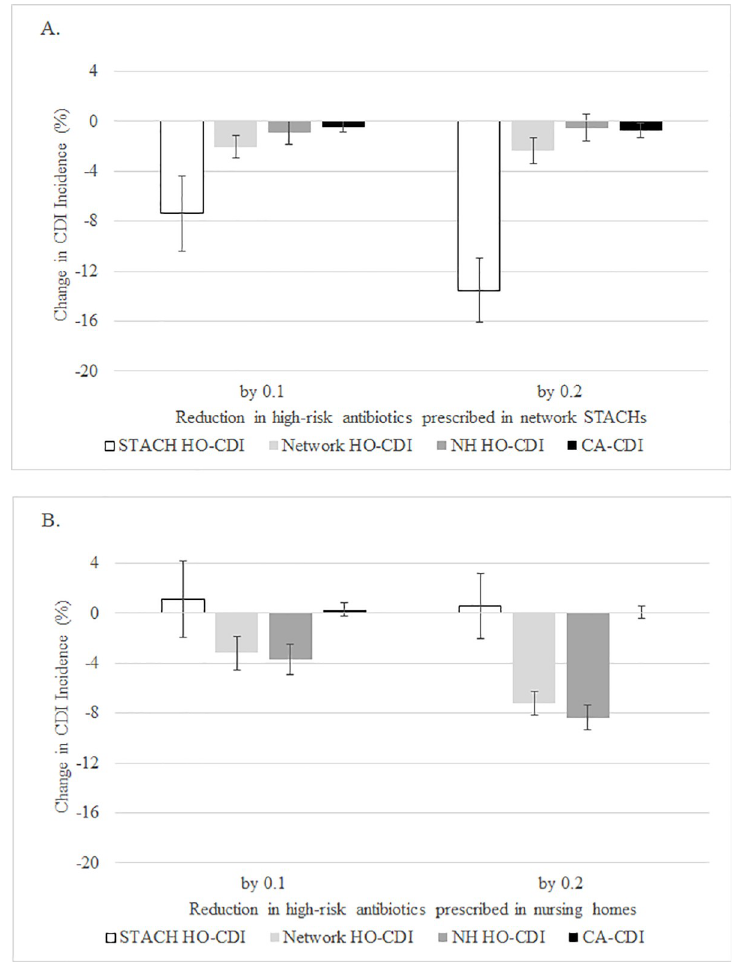
Fig 3. Clostridioides difficile infection (CDI) incidence and reductions in high-risk antibiotics prescribed. Scenarios as follows: (A) at network STACHs only; and (B) at nursing homes only. For each scenario, the relative proportion of CDI high-risk antibiotics was reduced by 0.1, in favor of a 0.1 increase in moderate-risk antibiotics prescribed, and by 0.2, in favor of a 0.2 increase in moderate-risk antibiotics prescribed. Results are based on 40 runs for each scenario. Error bars indicate 95% confidence intervals on the percent change. (STACH: short-term acute care hospital; HO-CDI: hospital (healthcare) onset-CDI; CA-CDI: community associated-CDI).